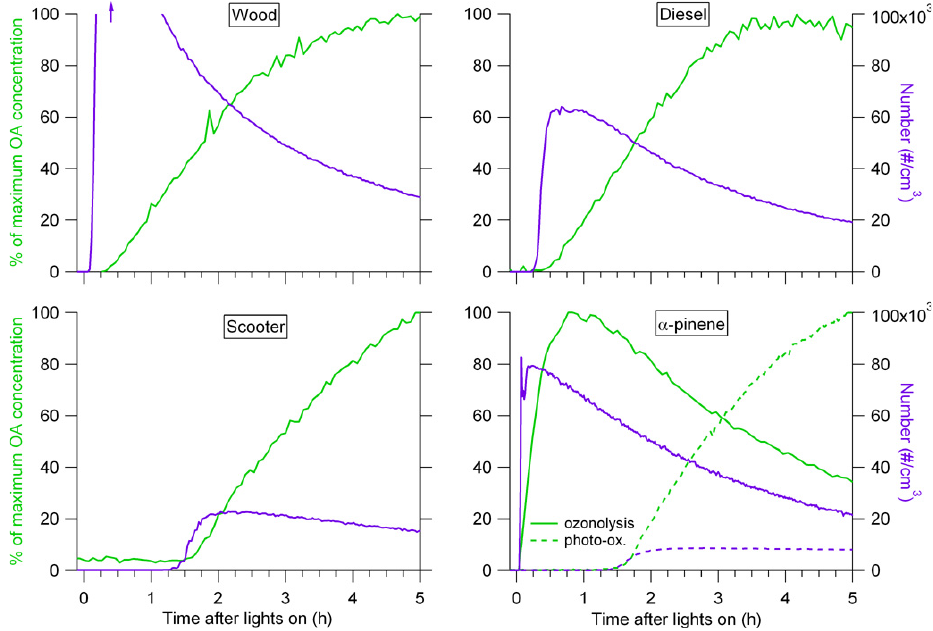
Fig. 2. Temporal evolution of the organic species normalized to the maximum concentration observed during five hours of aging and the number concentration. The time axis for the ozonolysis α -pinene experiment represents the time after the α -pinene addition to the chamber containing 500ppb